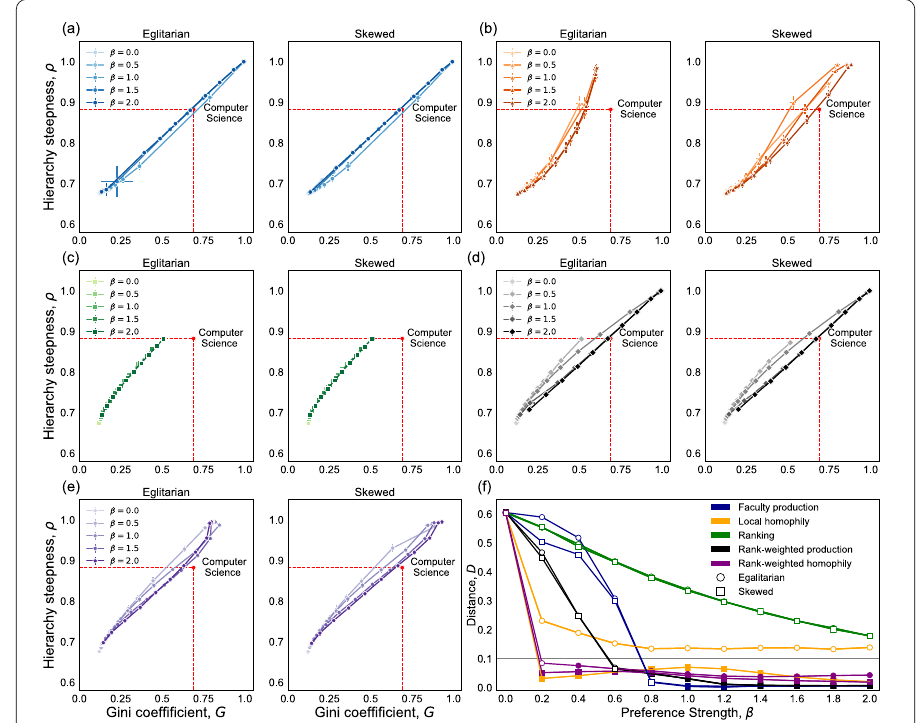
Figure S2 Best-fit values of the random hiring parameter p for the Computer Science faculty hiring network. ( a )–( e ) Steady-state values of Gini coefficient G and hierarchy steepness ρ , for the five hiring models and two initial conditions for different choices of β (for simplicity, we only show β ∈ { 0.0,0.5,1.0,1.5,2.0 } ). Each line is a parametric plot in which we vary the randomness parameter over 0 ≤ p ≤ 1, and hence all models and choices of β converge to the same point in inequality-space as p → 1. Red dashed lines show the empirical values of G and ρ for the Computer Science faculty hiring network. Results are averaged over 50 simulations, and error bars indicate standard deviations. ( f ) Euclidean distance between an averaged structural inequality ( G , ρ ) obtained from simulation and their pair of empirical values for the Computer Science hiring network. Filled markers represent β values that can reproduce G and ρ with distance D ≤ 0.1; open markers indicate D > 0.1 or a model is not able to reproduce the empirical